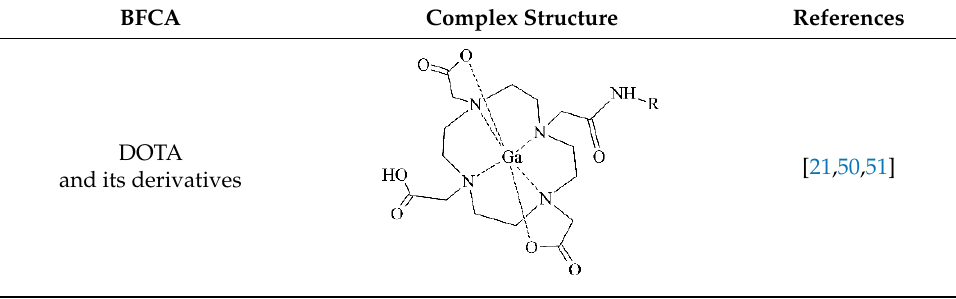
Table 3. The most common BFCA for 68 Ga-labeled compounds.